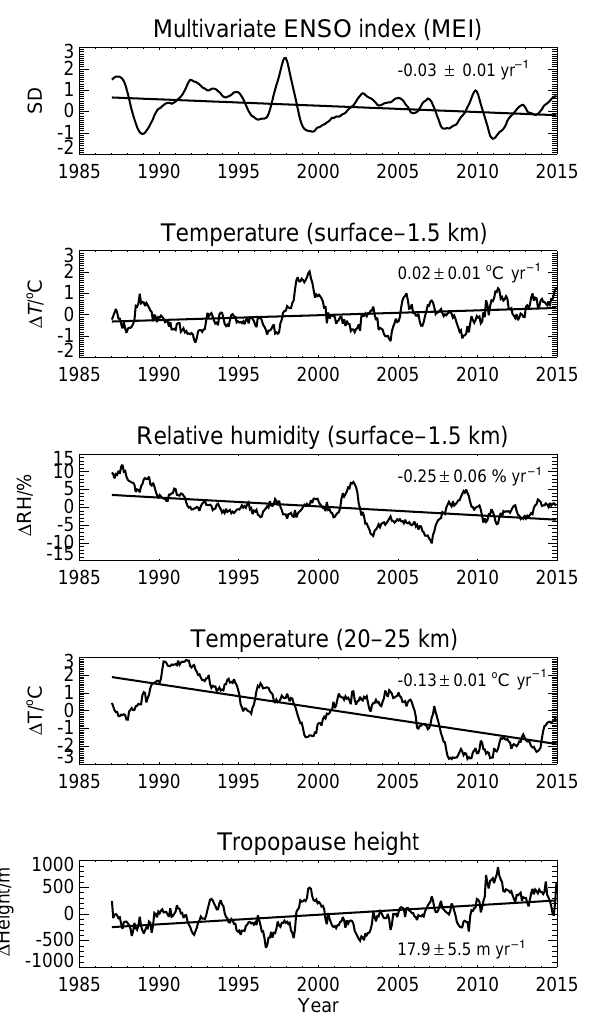
Figure 4. Time series of dominant climate/meteorological vari- ables, co-measured with O 3 at Lauder, with the exception of the multivariate ENSO index (MEI). Anomalies are monthly mean but are smoothed using a 13-month filter for display. Linear trends for all variables are noted in the